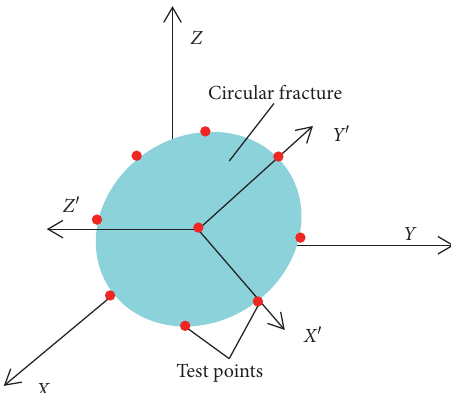
Figure 2: Slip test points on the periphery and center of a disc-shaped fracture in local